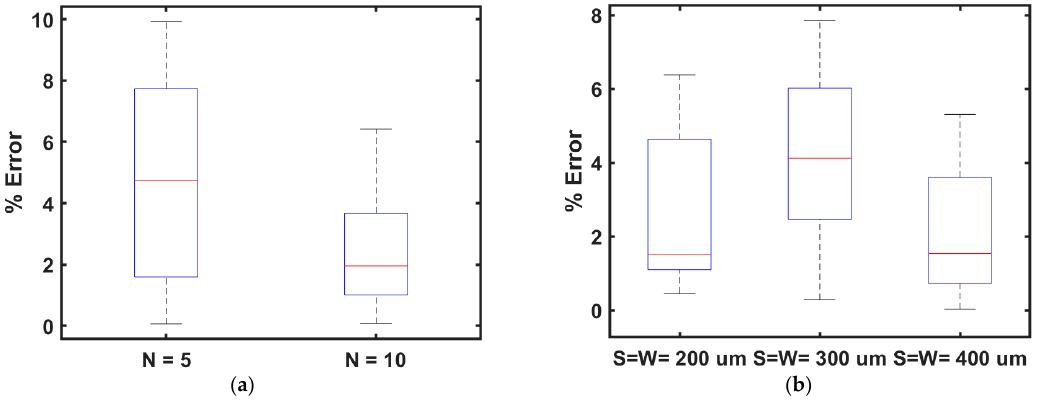
Figure 18. ( a ) Boxplot of the percentage error when trace width and separation were varied between 200 μ m and 600 μ m for fixed major-to-minor inner diameter ratio ( R ) = 3 for number of turns N = 5 and N = 10 ( b ). Table 14. Average percentage error and standard deviation of percentage error of inductance between the proposed model and measured